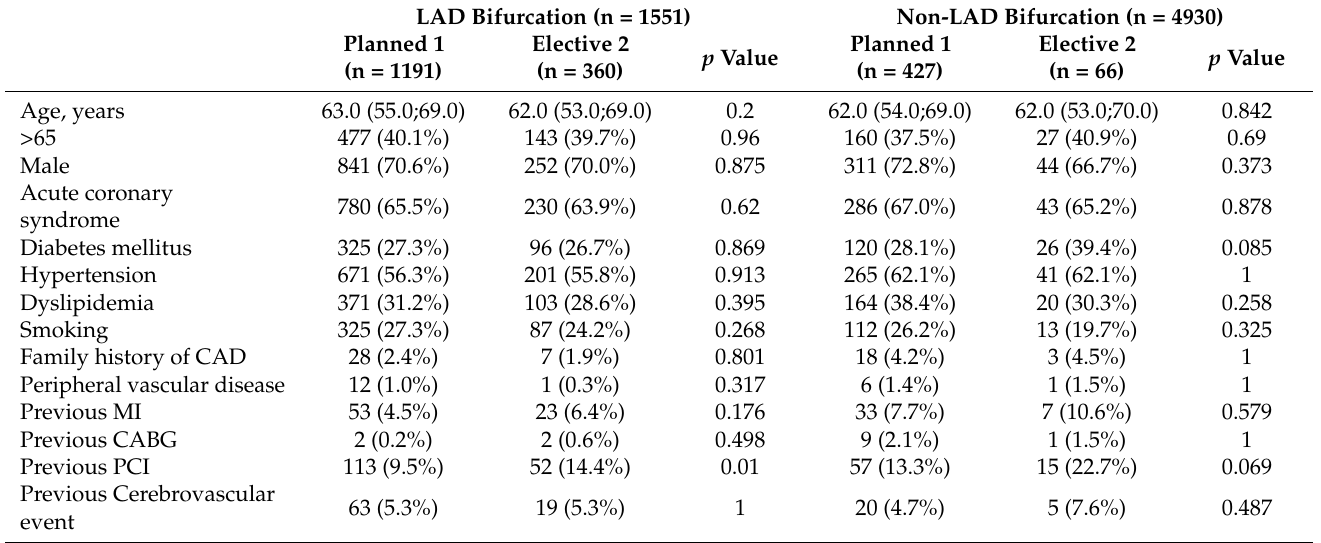
Table 1. Baseline and procedural